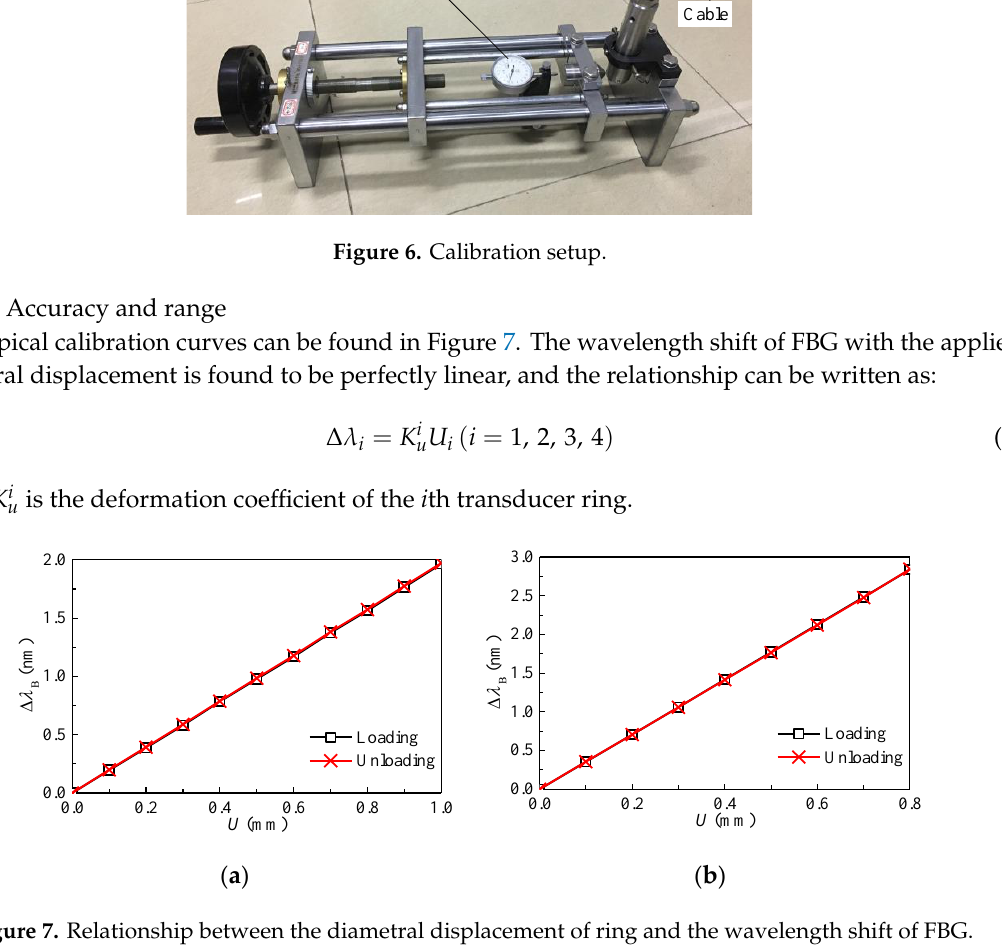
Figure 6. Calibration setup.